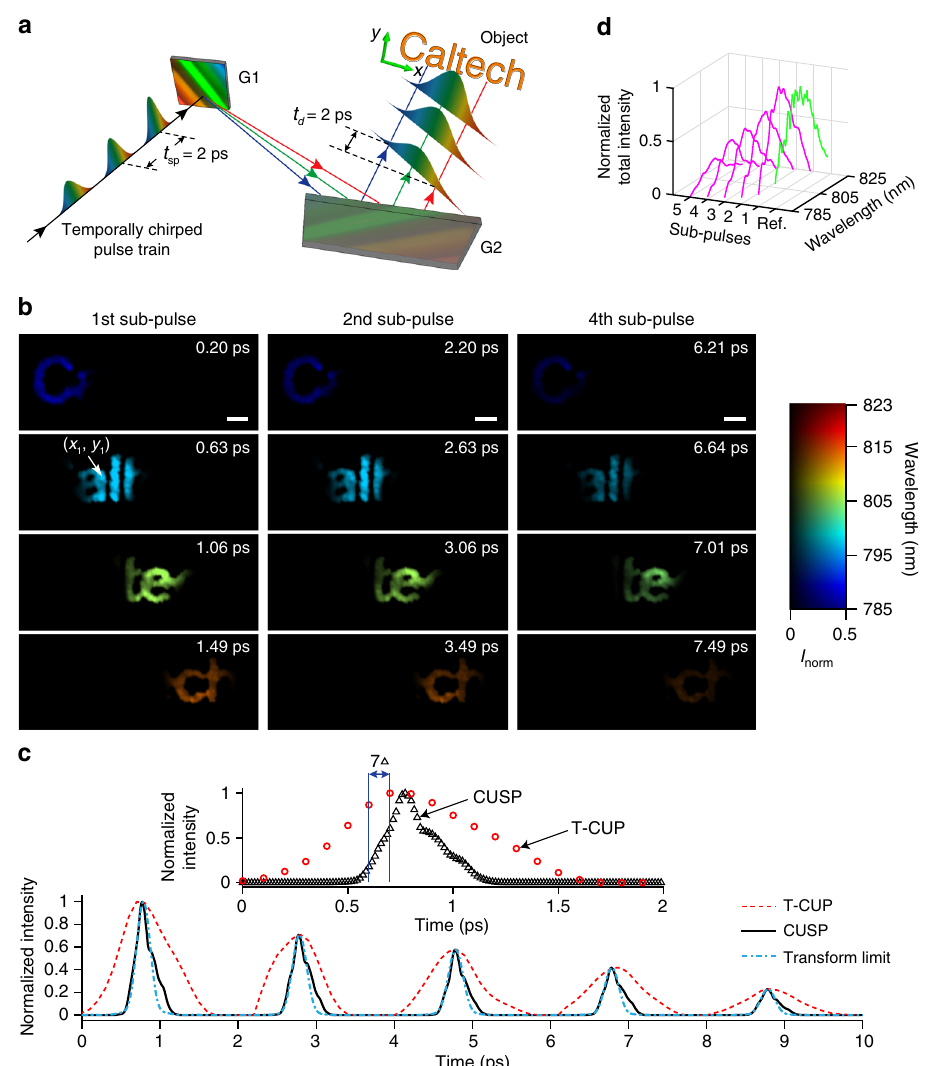
Fig. 2 CUSP imaging of an ultrafast linear optical phenomenon. a Schematic of the system used to impart both spatial and temporal chirps to the incoming pulse train using a pair of re fl ective diffraction gratings (G1 and G2). Each sub-pulse has a positive temporal chirp and illuminates the sample successively. b Selected frames from the reconstructed 70-Tfps movie of the spatially and temporally chirped pulse train sweeping a group of letters. Each frame is cropped from the full fi eld of view to reduce blank space. A 2D map uses color to represent illumination wavelength and grayscale to represent intensity. Intensity is normalized to the maximum, and its color map is saturated at 0.5 to display weak intensities better. See the entire sequence in Supplementary Movie 1. Scale bars: 1 mm. c Temporal pro fi le of the light intensity at ð x 1 ; y 1 Þ (white arrow in b ) from the state-of-the-art T-CUP (red dashed line), CUSP (black solid line) and the transform limit (cyan dash-dotted line) calculated based on the CUSP curve in the spectral domain. Inset: normalized light intensity pro fi les from CUSP and T-CUP in the fi rst 2 ps. d Spatially integrated total intensity over wavelength for fi ve sub-pulses (magenta lines). The reference spectrum (green line) was measured by a